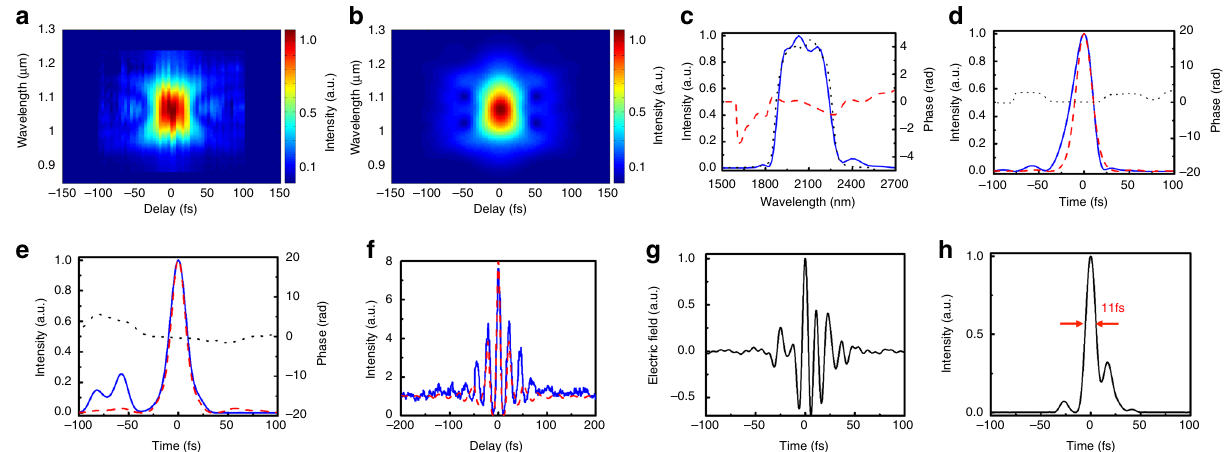
Fig. 3 Temporal characterisation of pump, signal and idler pulses, and calculated temporal pro fi le of the synthesised pulse. a – d The temporal characterisation of the 2.1- µ m pump pulse using the second-harmonic generation frequency-resolved optical gating (SHG FROG). The measured ( a ) and retrieved ( b ) FROG traces. c The retrieved spectrum ( blue solid ) and phase ( red dash ) in the FROG measurement. The separately measured spectrum is shown by the black dotted line that agrees well with the retrieved spectrum in FROG. d The retrieved ( blue solid ) and the calculated transform-limited ( red dash ) intensity pro fi les. The black dotted curve is the retrieved phase. The pulse duration of 26 fs FWHM of the pump is measured. e , f The temporal characterisation of the ampli fi ed signal and idler pulses using the SHG FROG and interferometric autocorrelator, respectively. e The retrieved ( blue solid ) and the calculated transform-limited ( red dashed line ) intensity pro fi les of the ampli fi ed signal pulses. The black dotted curve is the retrieved phase. A pulse duration of 20 fs in FWHM of the ampli fi ed signal is obtained. See Supplementary Fig. 7 for the measured and retrieved SHG FROG traces. f The measured autocorrelation trace of the idler pulse ( blue solid ) and the calculated autocorrelation trace from the measured spectrum assuming the pulse is transform limited ( red dashed line ). A pulse duration of 31 fs FWHM of the idler is obtained, assuming a Gaussian temporal pro fi le. g The calculated electric fi eld of the synthesised mid-IR pulse using the measured spectra of the signal and idler pulses. It is assumed that both the signal and idler pulses are transform limited, the idler leads the signal by 5 fs, and the CEP is zero for both pulses. h The calculated intensity pro fi le. The calculated duration of the synthesised pulse is 11 fs in FWHM corresponding to 0.8 cycle at 4.1 μ